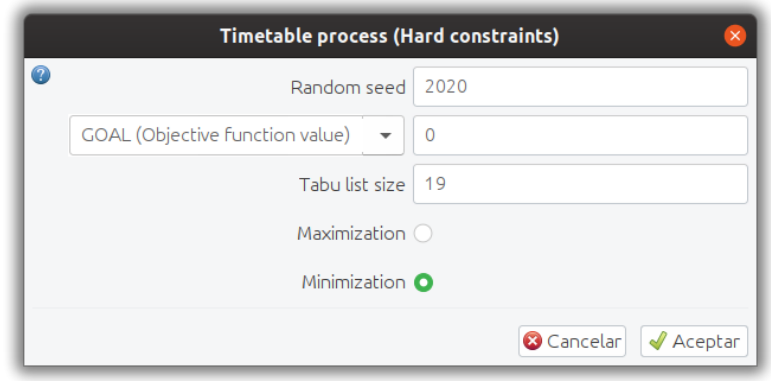
Figure 13. Sample configuration of the TS-PAC parameters for the timetable process (TTP) phase (hard constraints).